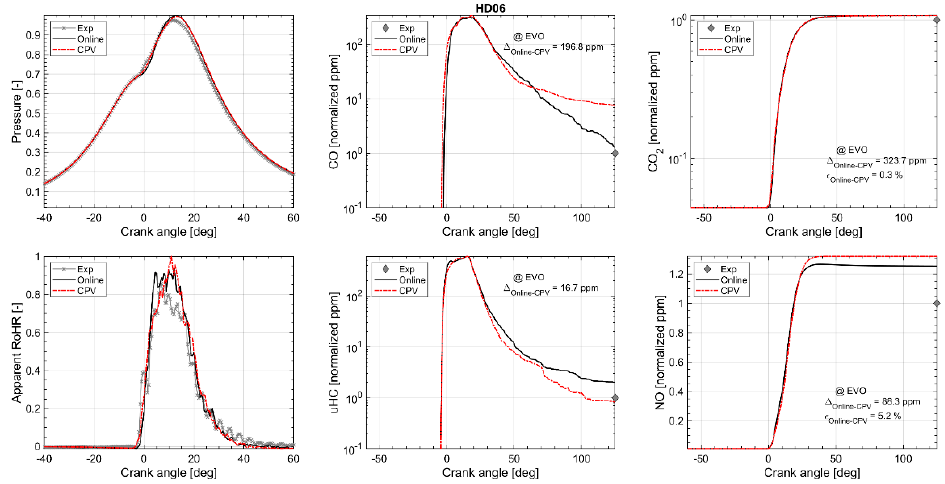
Figure A6. Engine performance and emissions for operating point HD06 (1200 rpm, 14.5 bar IMEP).